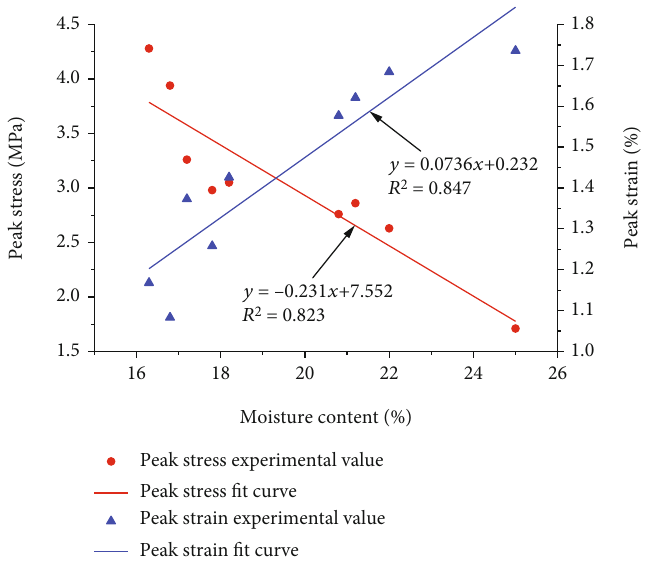
Figure 4: In fl uence curves of peak stress and peak strain of coal samples with di ff erent moisture contents.